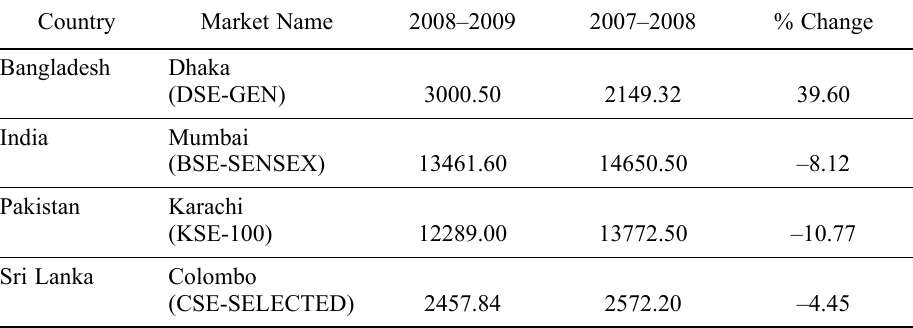
Table 1. (cid:3)(cid:38)(cid:82)(cid:80)(cid:83)(cid:68)(cid:85)(cid:76)(cid:86)(cid:82)(cid:81)(cid:3)(cid:82)(cid:73)(cid:3)(cid:86)(cid:87)(cid:82)(cid:70)(cid:78)(cid:3)(cid:80)(cid:68)(cid:85)(cid:78)(cid:72)(cid:87)(cid:86)(cid:3)(cid:83)(cid:72)(cid:85)(cid:73)(cid:82)(cid:85)(cid:80)(cid:68)(cid:81)(cid:70)(cid:72)(cid:3)(cid:76)(cid:81)(cid:3)(cid:54)(cid:82)(cid:88)(cid:87)(cid:75)(cid:3)(cid:36)(cid:86)(cid:76)(cid:68)(cid:3)(cid:11)(cid:21)(cid:19)(cid:19)(cid:27)(cid:177)(cid:21)(cid:19)(cid:19)(cid:28)(cid:3)(cid:68)(cid:81)(cid:71)(cid:3)(cid:21)(cid:19)(cid:19)(cid:26)(cid:177)(cid:21)(cid:19)(cid:19)(cid:27)(cid:12)